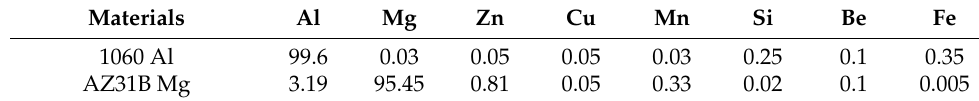
Table 1. Chemical composition of 1060 Al and AZ31B Mg (wt.%).